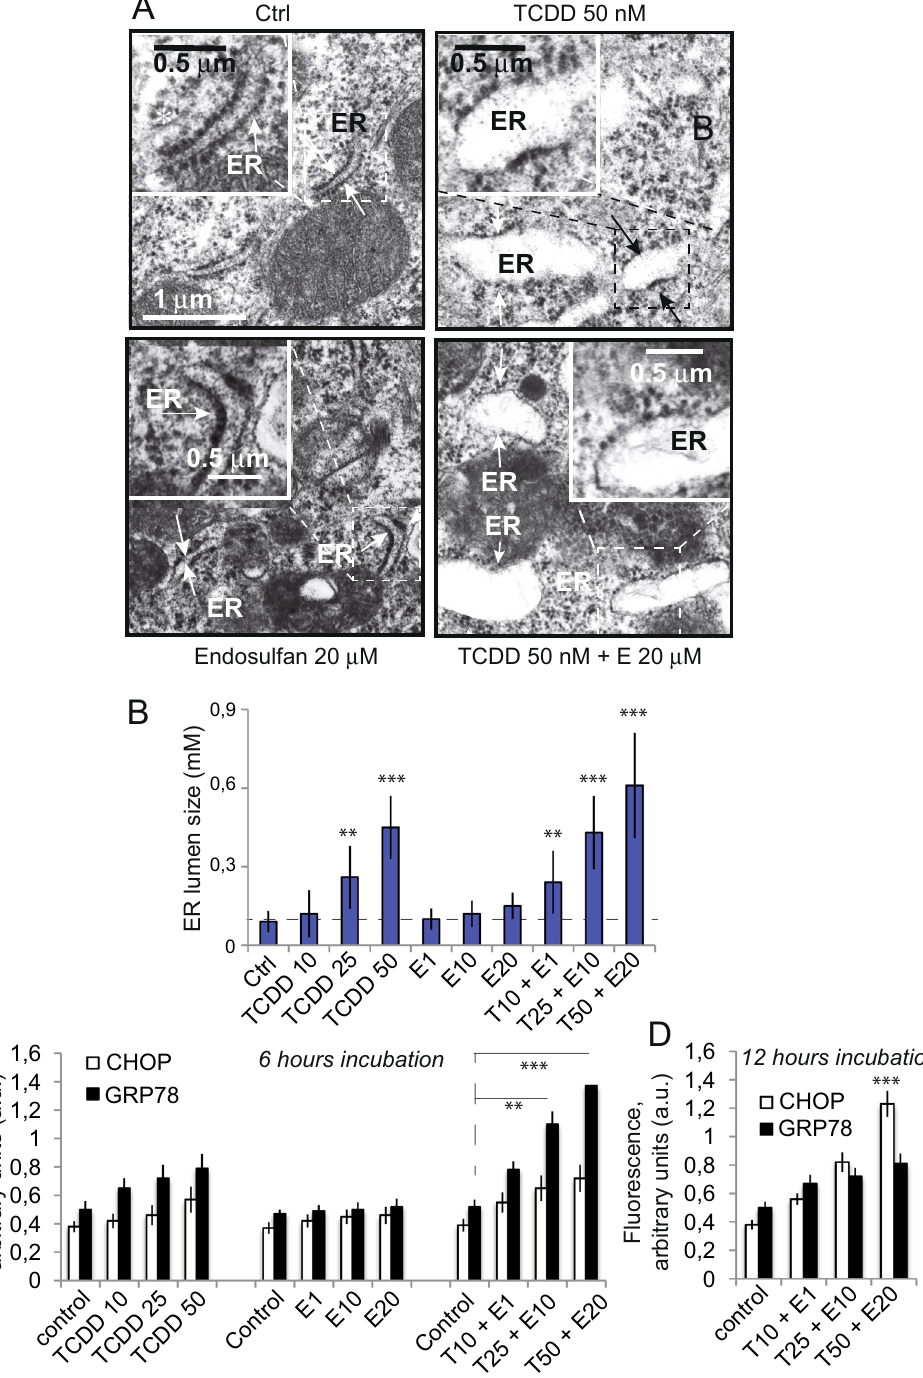
Figure 3. TCDD + endosulfan induced ultrastructural ER alterations in Caco-2 cells. ( A ) Caco-2 cells were treated with or without different substances separately or in cocktails (i.e., control; endosulfan 20 µ M; TCDD 50 nM and TCDD 50 nM + Endosulfan 20 µ M) for 24 h and then examined by transmission electron microscopy. Representative images from five independent experiments are shown. ER, endoplasmic reticulum; M, mitochondria; N, nucleus; NmL nuclear membrane lumen; SF, stress fibers. Arrows indicate normal or dilated ER. * P < 0.05 compared with the control group. Representative images from five independent experiments are shown. ( B ) Histogram presentation of the quantification of the width of the ER lumen (in µ m) in Caco-2 cells treated with either TCDD 10, 25 or 50 nM; endosulfan 1, 10 or 20 μ M or a mixture of TCDD + Endosulfan (respectively 10 nM + 1 μ M; 25 nM + 10 μ M or 50 nM + 20 μ M). Data are shown as mean ± SD (n = 11). ( C and D ) Flow cytometric determination of the CHOP and GRP78 activities linked to ER stress induced by TCDD, α -E and TCDD + α -E treatements. ( C ) After 6 h treatment and ( D ) after 12 h treatment for the mixture